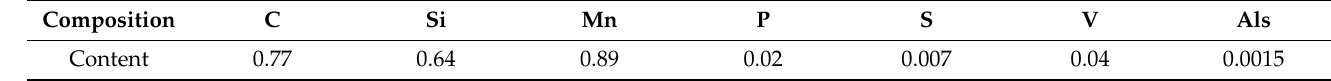
Table 1. Chemical composition of U75V steel